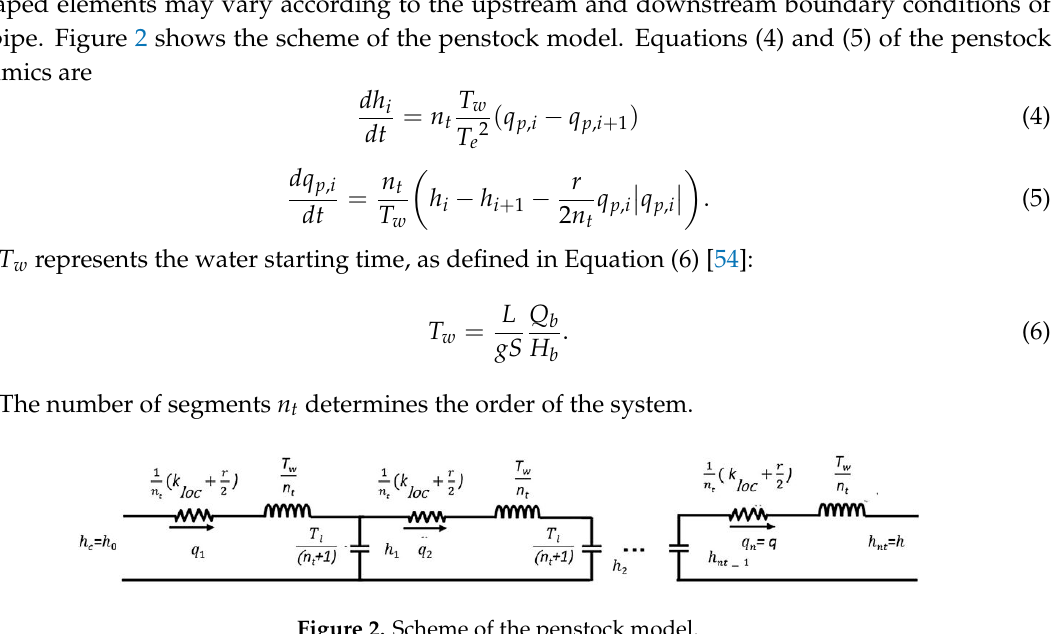
Figure 2. Scheme of the penstock model.